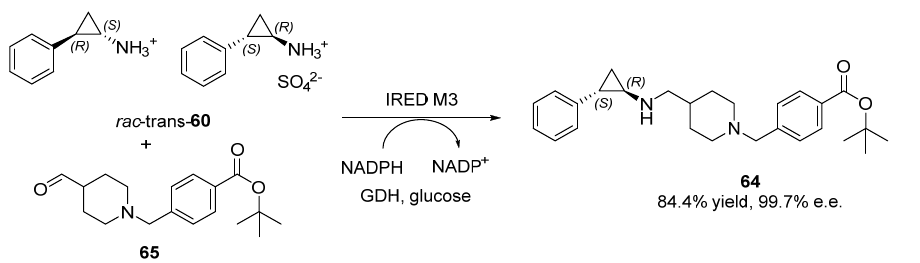
Scheme 16. Application of imine reductases to the manufacture of GSK2879652.